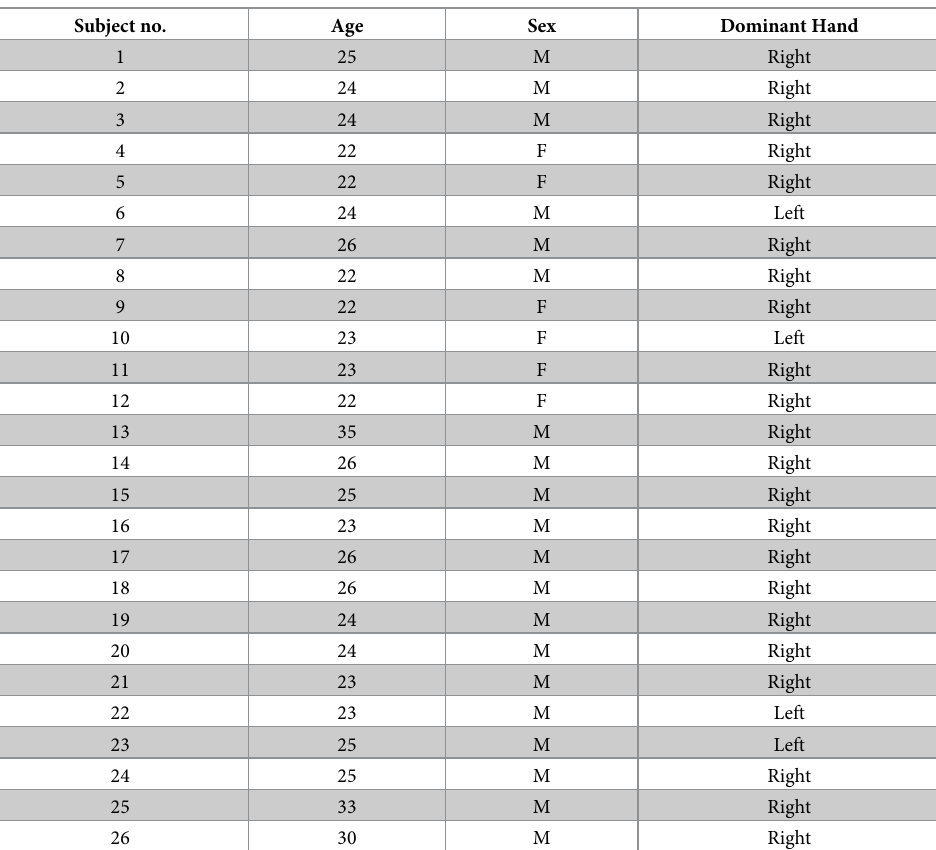
Table 1. Subject information: Age, sex, and dominant hand. Subject